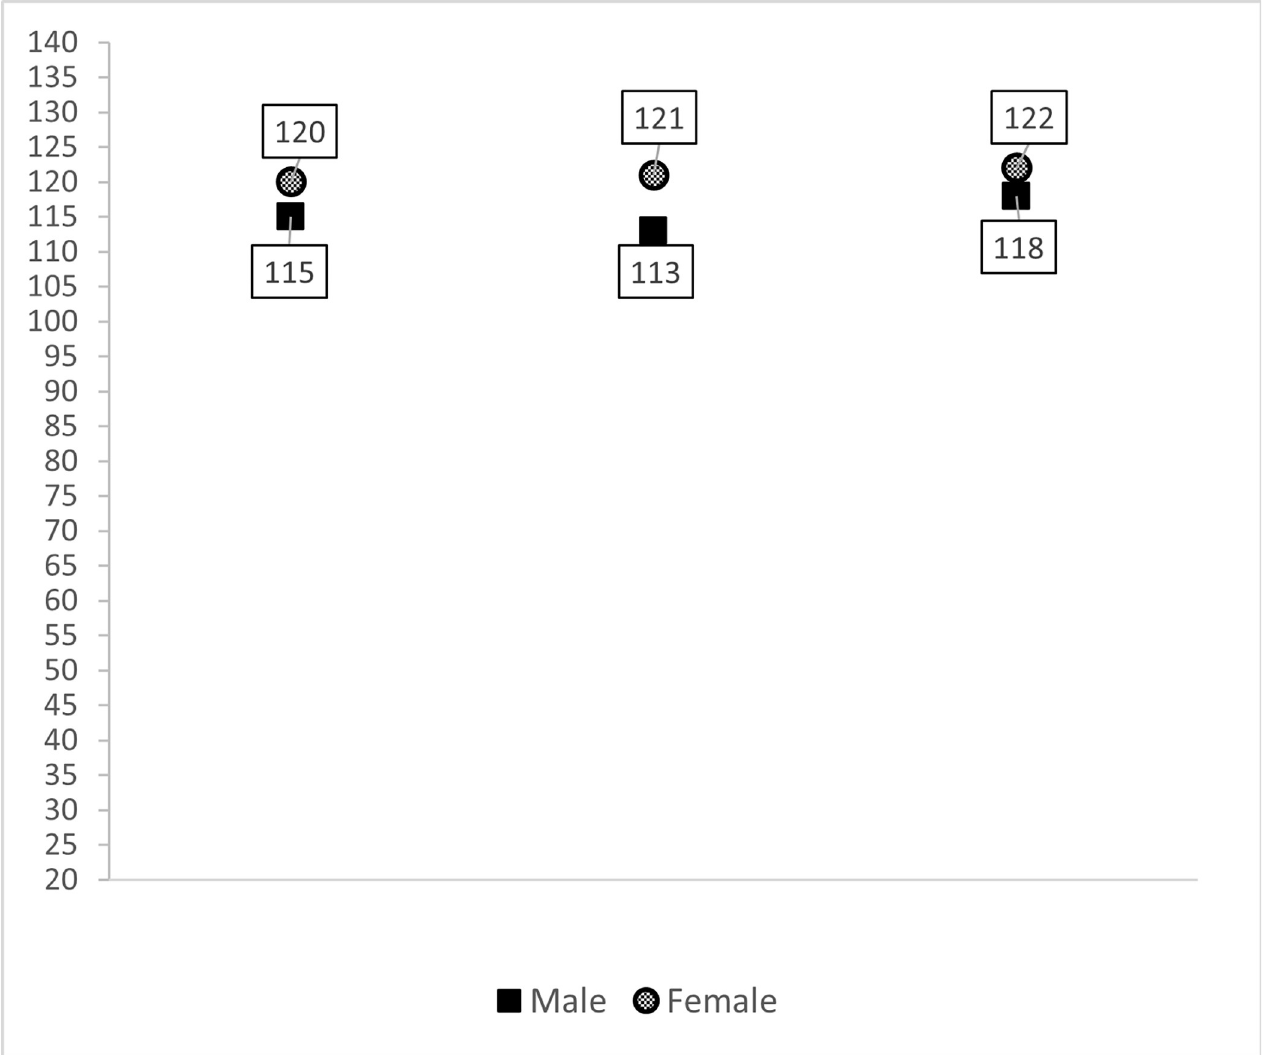
Fig 1. Overall Jefferson Scale of Empathy (JSE) scores based on the academic year and gender of 2,264 medical students. https://doi.org/10.1371/journal.pone.0267172.g001 The overall mean well-being (MSWBI) score was 2.76 points (SD = 2.19) for men and women had 3.05 points (SD = 2.13); the mean difference was 0.29 points (95% CI 0.09–0.50; p = 0.004; Cohen’s d = 0.13). In addition, 41.6% of the students (n = 944) scored 4 or higher (psychological distress). This percentage was significantly higher in women than in men (43.4% vs. 36.7%; p = 0.007; see Fig 2). Students who preferred general specialities (internal medicine, psychiatry, pediatrics, or family medicine) scored a mean JSE score of 121.85 points (SD = 11.62). Those who chose other medical specialities (cardiology, digestive, nephrology, etc.) had 119.80 points (DE = 12.33) points, and those who chose surgical-technological (surgeries, radiodiagnosis, etc.) and non-clinical (clinical analysis, pathological anatomy, or preventive medicine) special- ities scored 118.46 (SD = 12.11) and 114.86 (SD = 13.91) points, respectively. In the post-hoc tests of multiple Bonferroni comparisons, these differences were statistically significant for all subgroups, except when the scores of those who chose other medical specialities versus